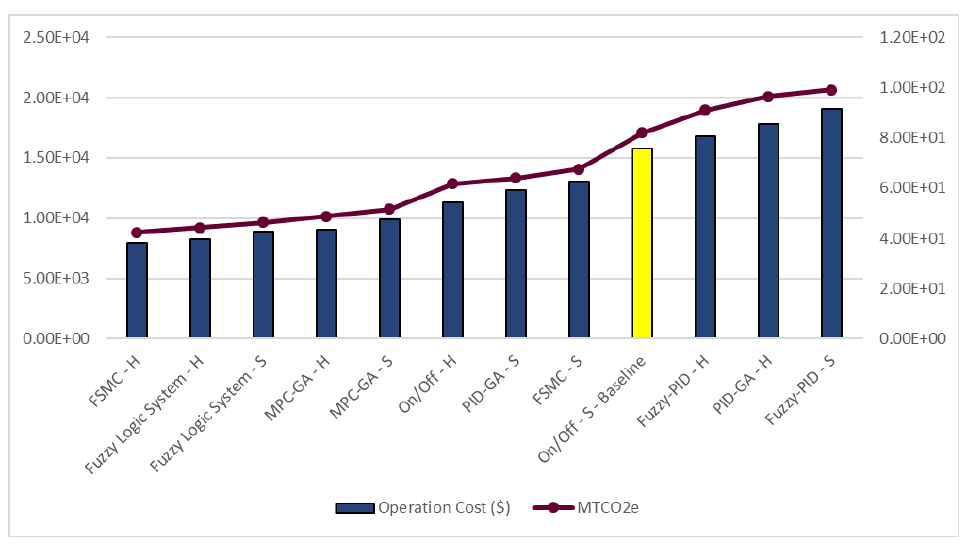
Figure 13. Operational Cost (left vertical axis) and CO 2 emission (right vertical axis) of applying different control algorithms in steam (S) and hydronic (H) system.